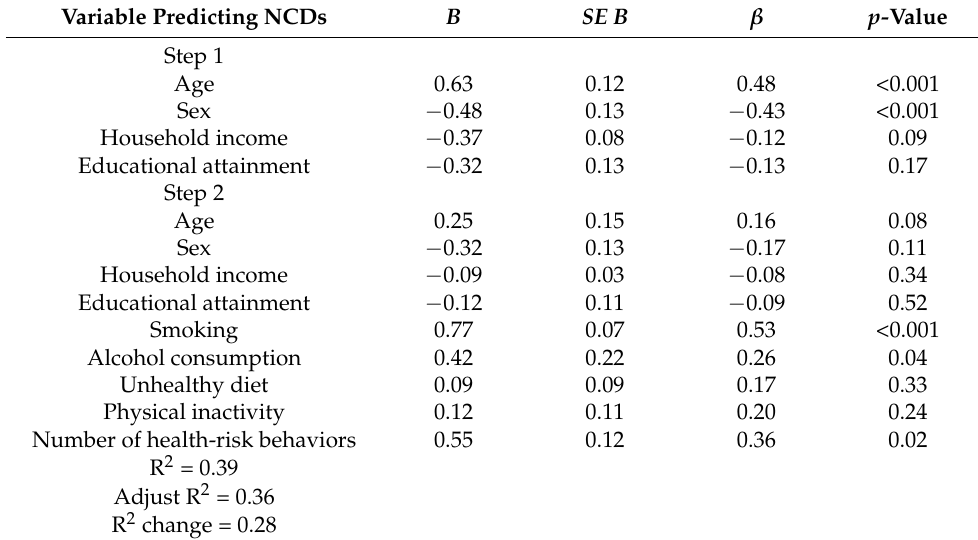
Table 5. Summary of multiple regression for variables predicting NCDs ( N =